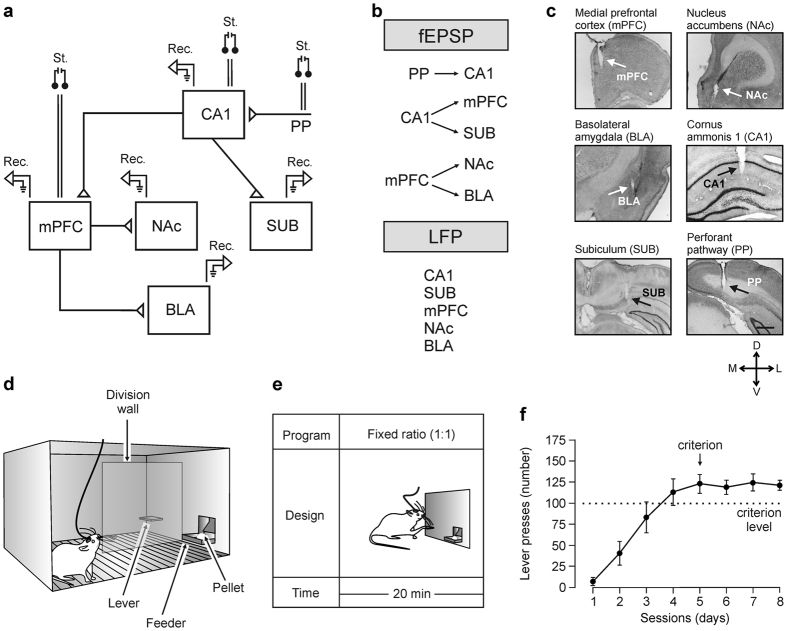
Experimental design.(a,b) Rats were divided in four groups and implanted with: (i) bipolar stimulating (St.) electrodes in the left PP and recording (Rec.) electrodes in the ipsilateral hippocampal CA1 area; (ii) stimulating electrodes in the left CA1 area and recording electrodes in the ipsilateral mPFC and SUB; (iii) stimulating electrodes in the mPFC and recording electrodes in the ipsilateral NAc and the BLA; and (iv) recording electrodes in the left CA1, SUB, mPFC, NAc, and BLA. (c) Representative photomicrographs of recording electrodes implanted in the mPFC, NAc, BLA, CA1, and SUB and of stimulating electrodes implanted in the PP. Calibration bar is 0.5 mm. Abbreviations: D, L, M, and V, dorsal, lateral, medial, and ventral. (d,e) In a first experimental step, animals were trained in a Skinner box to press a lever to obtain a pellet of food with a fixed-ratio (1:1) schedule. Sessions lasted for 20 min. (f) Acquisition curve collected from a group of animals (group 1, PP-CA1, n = 10) during the fixed-ratio (1:1) task. Each animal was switched to the following experimental task on reaching asymptotic values for ≥3 consecutive sessions (arrow).